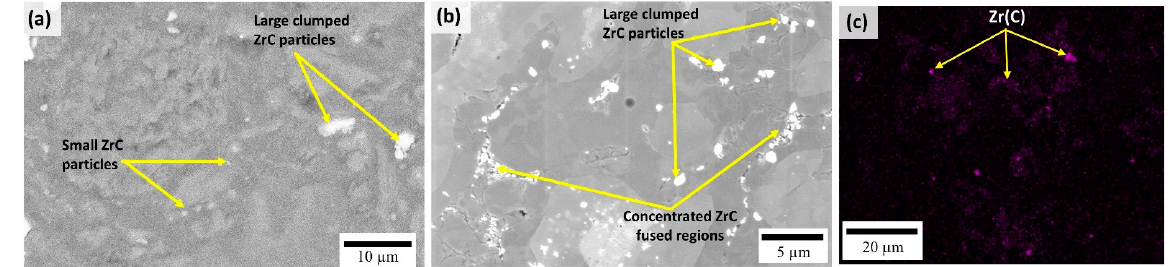
Figure 5. Secondary electron SEM micrographs of the sintered Fe-5 vol.% ZrC alloys milled by ( a ) Spex for 2 h ( b ) Retsch for 2 h, ( c ) EDS (energy-dispersive X-ray spectroscopy) elemental map of the Zr signal. The bright contrast is from the agglomerated ZrC NPs.